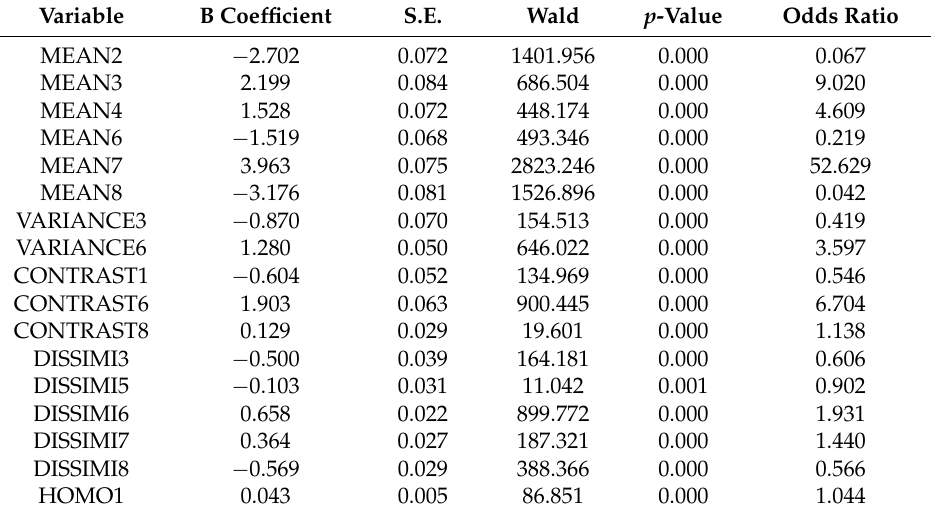
Table 3. Feature selection results of PBIA with LR